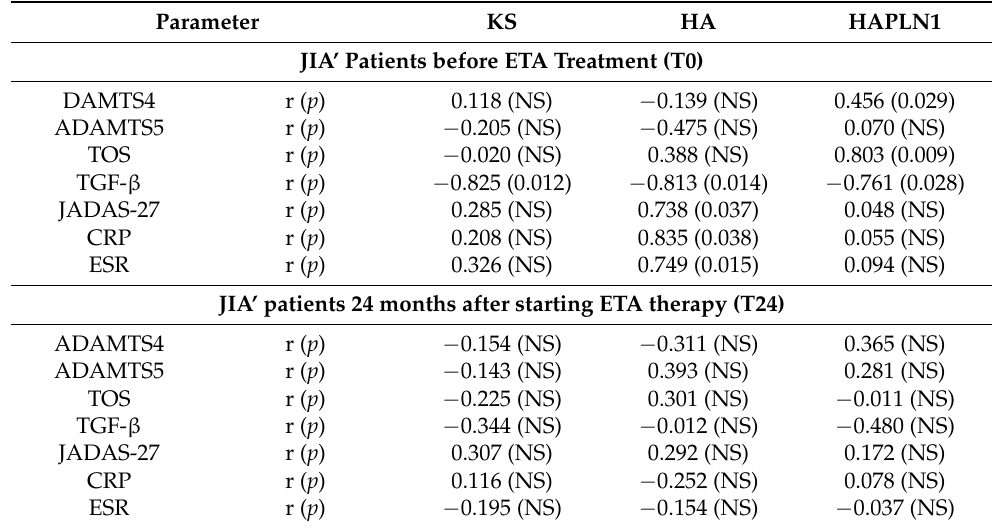
Table 3. Correlation analysis between plasma KS, HA, HAPLN1 and ADAMTS4, ADAMTS5, TOS, TGF- β , JADAS-27, CRP, and ESR levels in JIA patients before ETA treatment (T0) and 24 months after starting ETA therapy